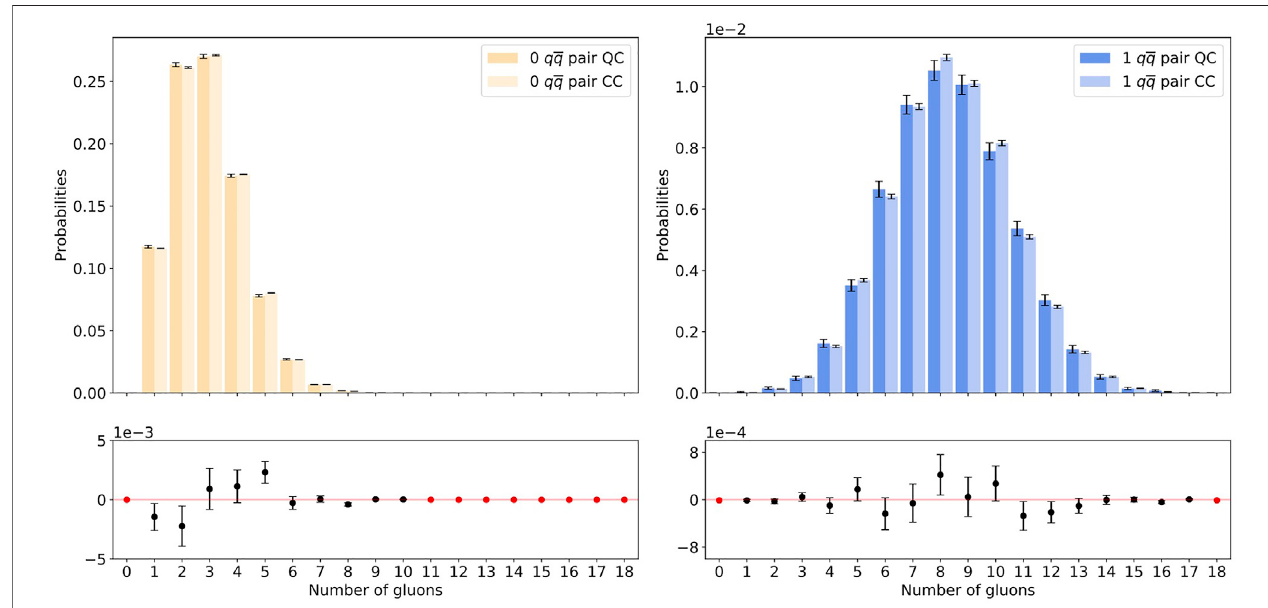
FIGURE 1 | Probability distributions of the number of gluons measured after a 31-step parton shower for the classical (CC) and quantum (QC) algorithms for the scenario where there are zero quark-antiquark pairs (left) and exactly one quark-antiquark pair (right) in the fi nal state. From [25].